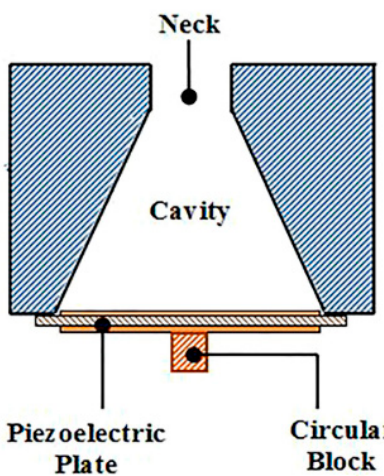
Figure 9. Schematic diagram of the proposed AEH, which is equipped with a conical Helmholtz resonator and a piezoelectric conversion device. Reproduced with permission from [40]; published by American Institute of Physics, 2016.